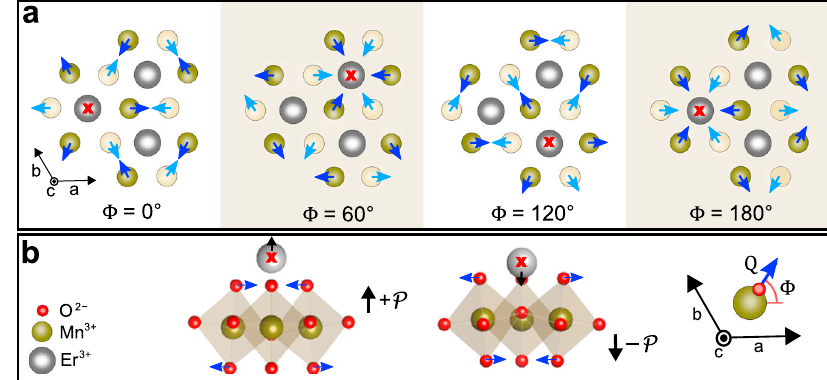
Fig. 1 Distortive-ferroelectric order of ErMnO 3 . a Top view of the ErMnO 3 unit cell for different values of the azimuthal angle Φ associated with the tilt of the MnO 5 bipyramids. Dark and bright circles denote Mn 3 + ions in the upper and lower halves of the unit cell. Dark and bright blue arrows indicate the associated shift of apical O 2 − ions caused by the bipyramidal tilt. The trimerization centre is marked with a red cross. b Coordinated tilting of three corner- sharing MnO 5 bipyramids displaces the Er 3 + ions along the c axis, and induces improper ferroelectricity ( ± P polarization states). The inset with the coordinate system de fi ning Q and Φ , in the bottom right, takes the Mn 3 + ion in the centre of the three Er 3 + ions in ( a ) as